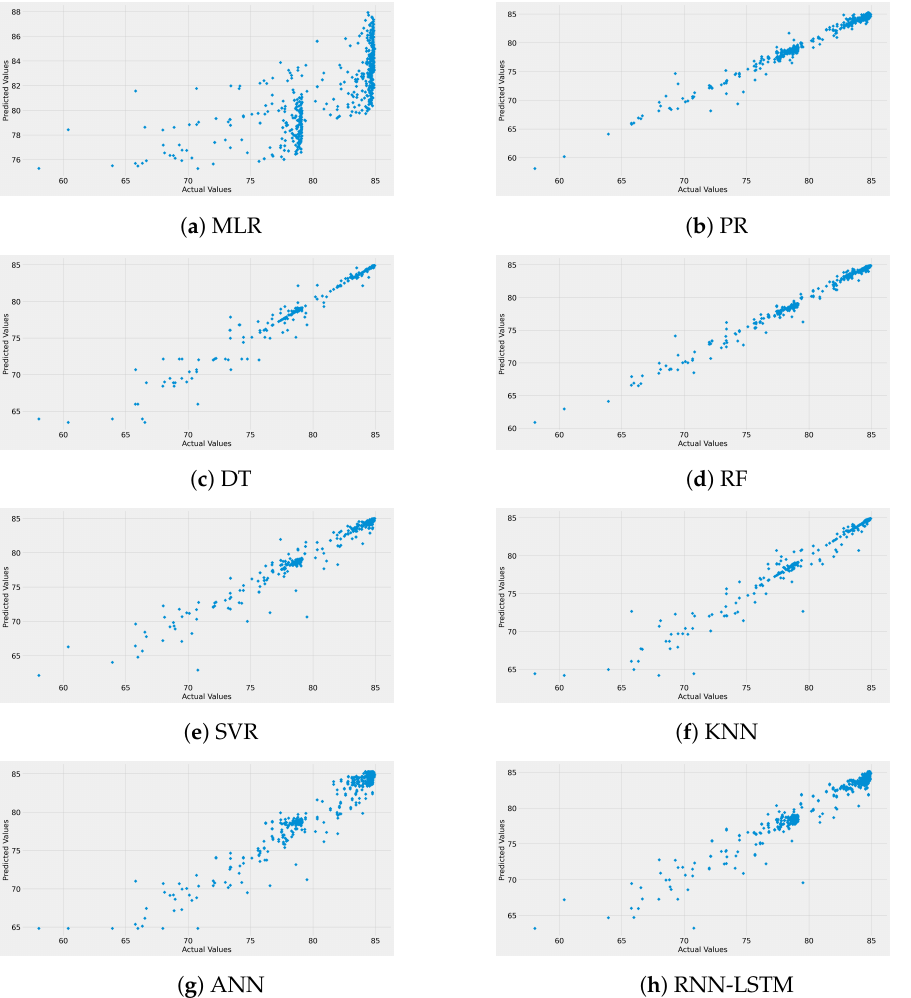
Figure 8. Measured vs. predicted path loss data for each model. Table 2. Runtime comparison of the adopted ML